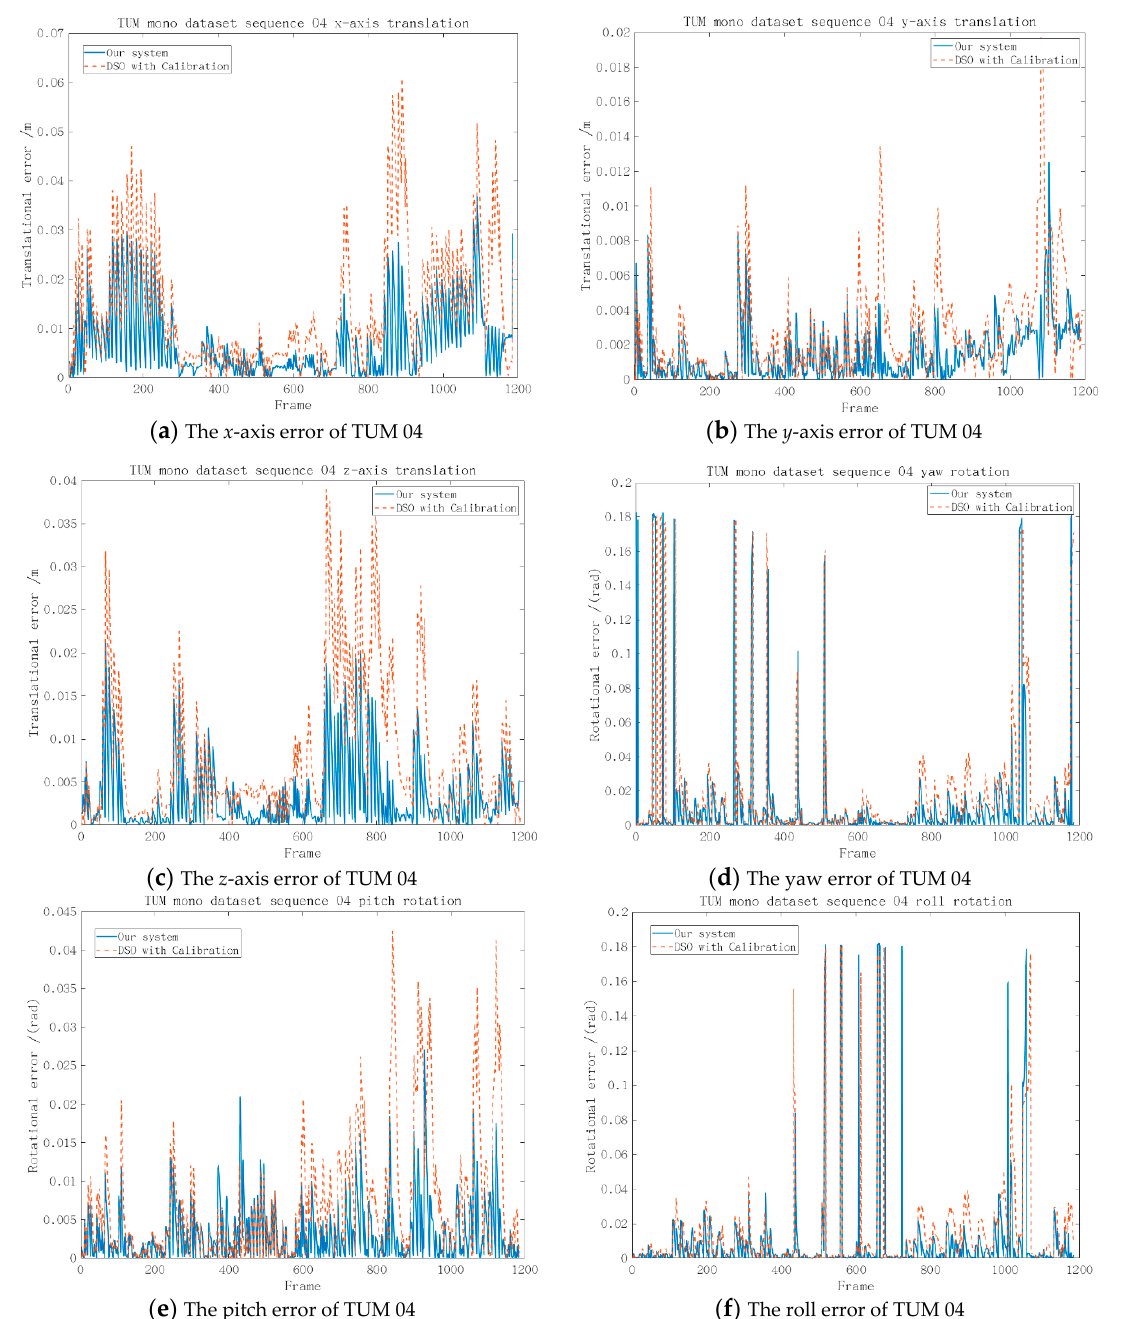
Figure 8. The error of the 6-degree of freedom (6-DoF) on TUM-Mono sequence 04 with respect to the ground truth between our system and the enhanced DSO [12] and [14].